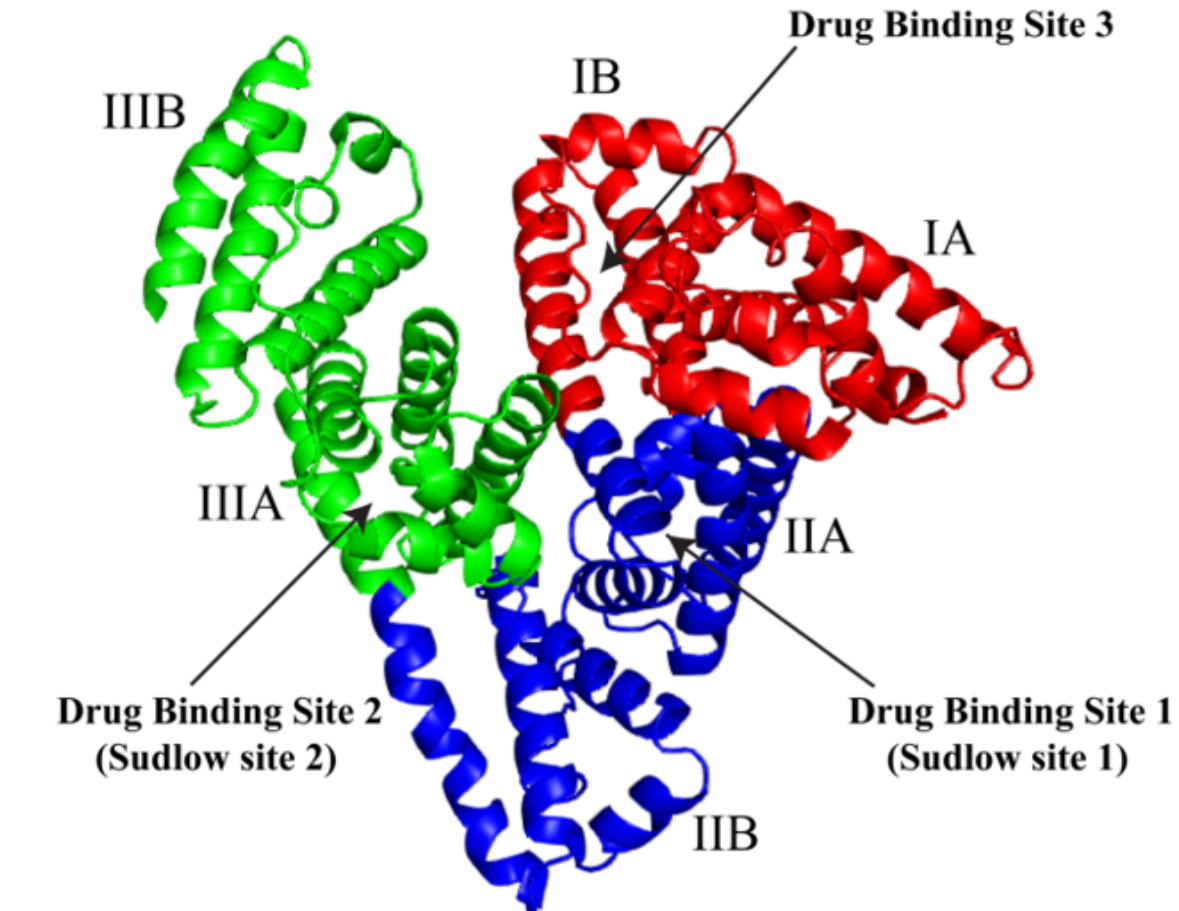
Figure 1. Domain organization of human serum albumin. Domain I (red), domain II (blue), and domain III (green). The 3-D model was generated by PyMOL using 1AO6 PDB file.